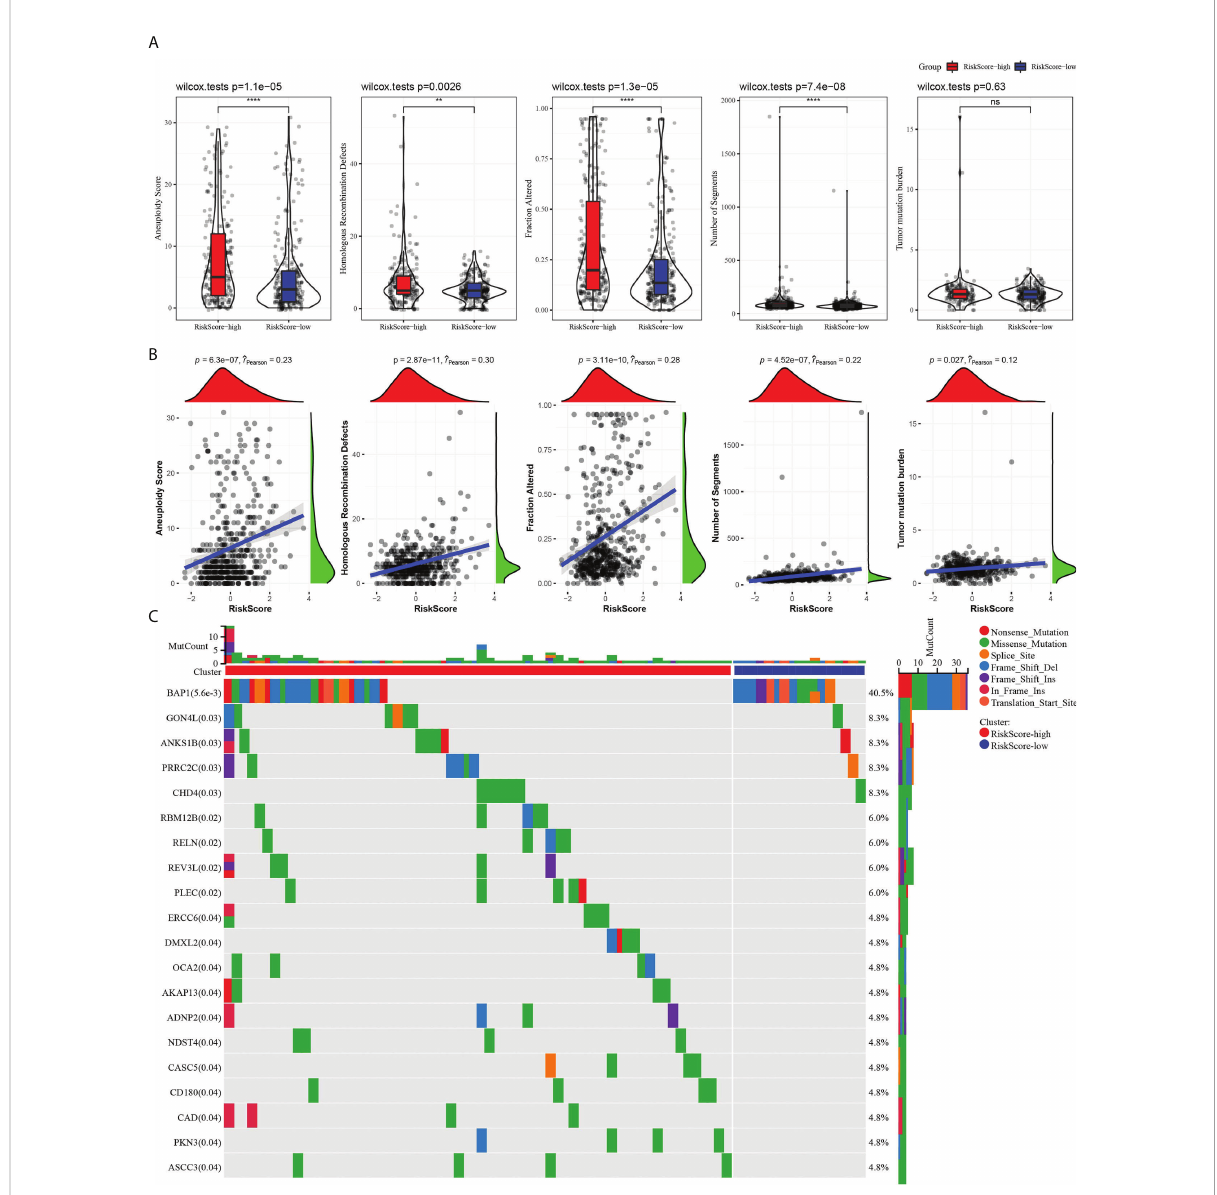
FIGURE 7 The risk score characterized by distinct mutation pro fi les. (A) Aneuploidy score, HRDs, fraction altered, number of segments, and TMB between high-risk and low-risk subgroups. (B) Correlation analysis between risk score and aneuploidy score, HRDs, fraction altered, number of segments, tumor mutation burden. (C) Distribution of gene mutations in the high-risk and low-risk subgroups. ** P < 0.01, **** P < 0.0001. ns, not signi fi